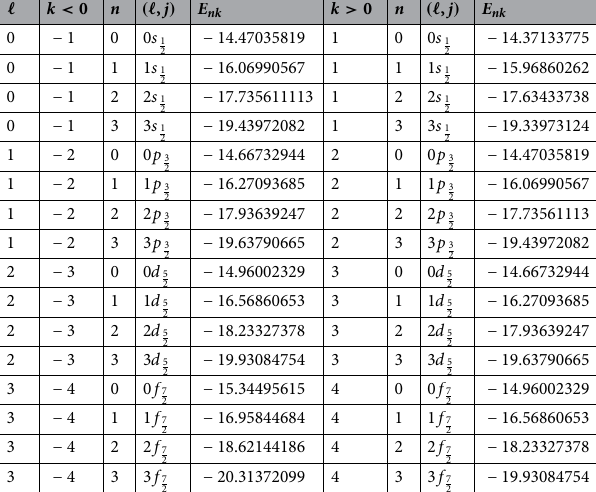
Table 8. Numerical values for pseudospin symmetry energies for A ( (cid:31) = c = 1 ) unit